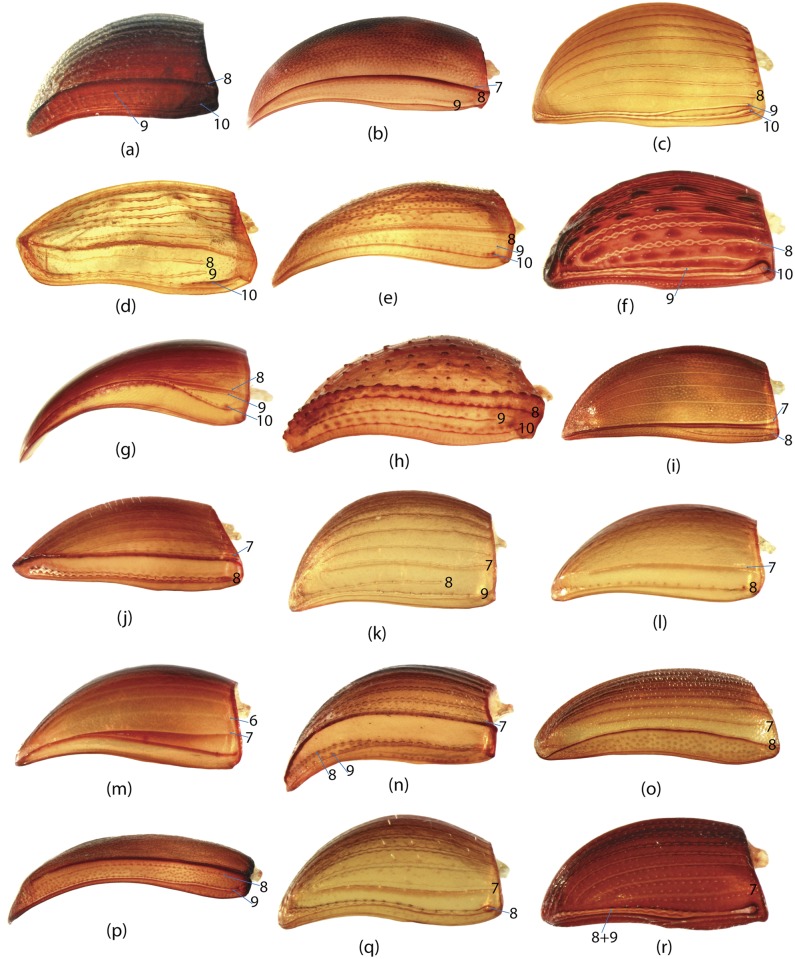
Elytra of Scarabaeinae.a, Dwesasilvasedis medinae; b, Anachalcos convexus; c, Coptodactyla nitida; d, Amphistomus calcaratus; e, Boletoscapter cornutus; f, Demarziella interrupta; g, Diorygopyx tibialis; h, Onthobium gutierrezi; i, Bdelyrus seminudus; j, Bdelyropsis bowditchi; k, Tesserodoniella elguetai; l, Canthochilum tureyra; m, Canthonella silphoides; n, Cryptocanthon paradoxus; o, Paracanthon sp.; p, Streblopus opatroides; q, Zonocopris gibbicollis; r, Genieridium margareteae; a-r, right elytron, lateral view. Elytral striae are enumerated; indistinct striae or their traces are marked by *.